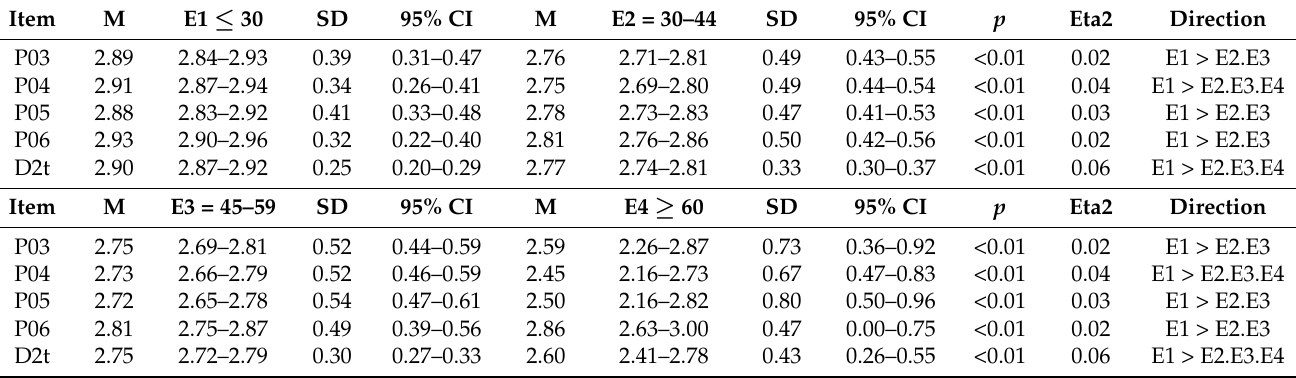
Table 6. ANOVA for independent samples by age group for dimension